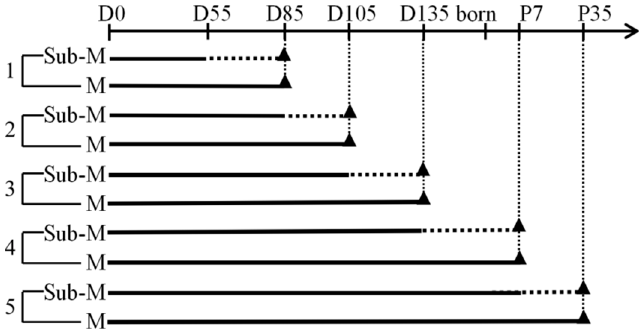
Figure 1. Timelines of the maternal feed restriction experiment. The experiments were divided into five groups (1–5), each group included sub-maintenance (Sub-M) nutrition ewes (n = 3) and maintenance (M) nutrition ewes (n = 3). The timeline at the top of the diagram represents the gestational period. D0: day 0 of gestation; D55: days 55 of gestation; D85: days 85 of gestation; D105: days 105 of gestation; D135: days 135 of gestation; P7: postnatal day 7; P7: postnatal day 35. The solid line represents the maintenance nutrition feeding period, the dotted line represents the Sub-maintenance nutrition feeding period. Triangle represents sampling time points. The vertical dotted lines are used to align the sampling time points of the Sub-M and M.